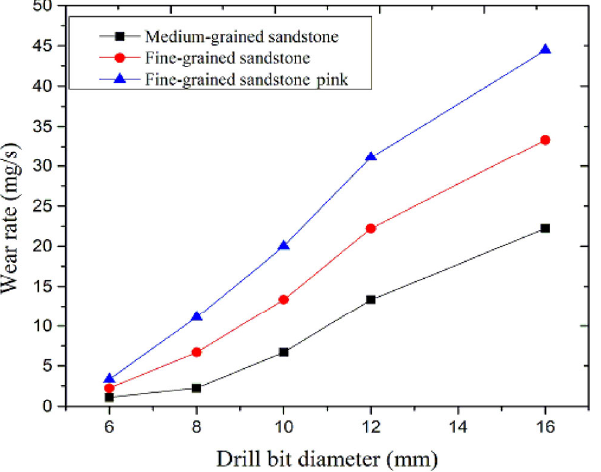
Fig. 7 Effect of drill bit diameter on the wear rate of the drill